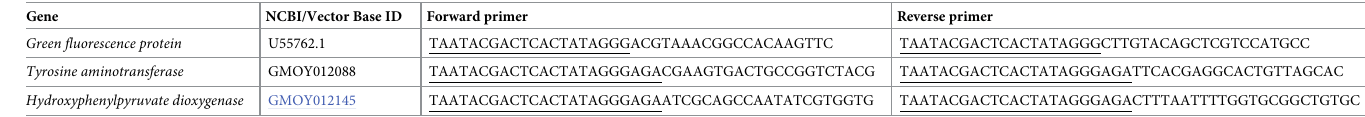
Table 1. Sequences of the primers used to amplify target genes for RNAi experiments. T7 promoter sequences that were necessary for transcription are underlined. Gene NCBI/VectorBaseID